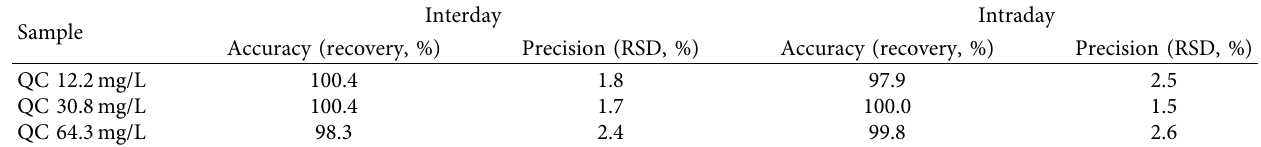
Table 1: Interday and intraday accuracy and precision of QC samples of vancomycin from LiHep